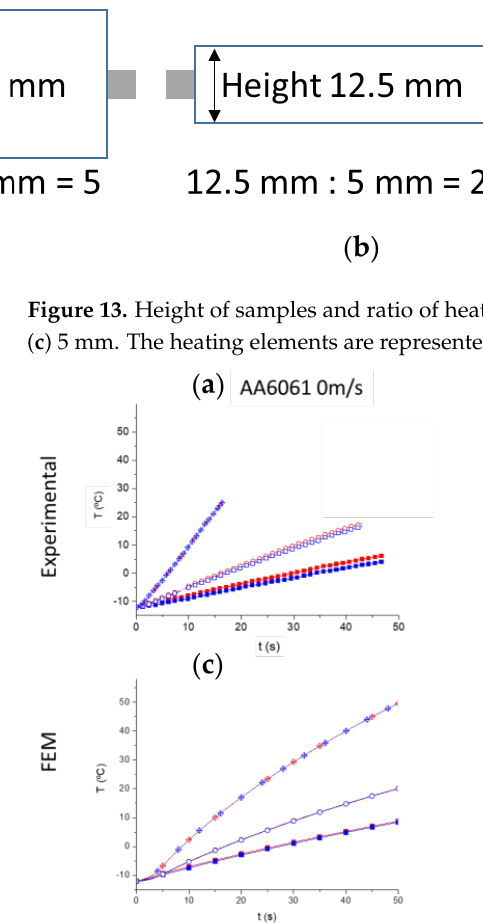
Figure 14. HS and CS temperature on different-sized samples under the 0 m/s condition. ( a ) AA6061. ( b ) PTFE. ( c ) Modeled AA6061 ( d ) Modelled PTFE.